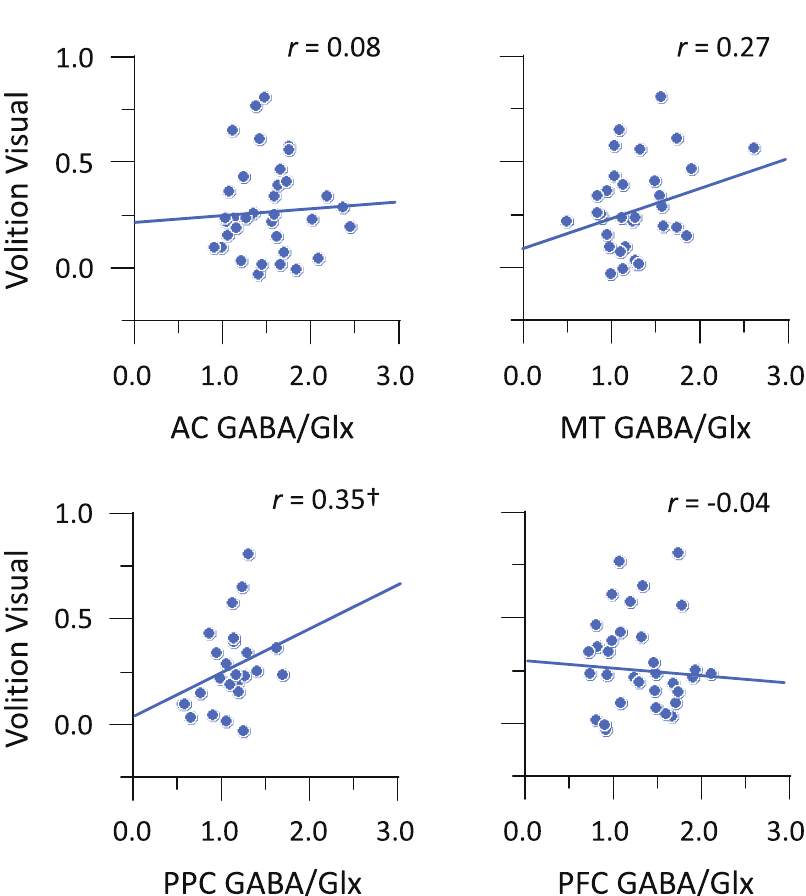
Figure 7. Correlations between MRS measure and volitional control for moving plaids. Amounts of effective volitional control as a function of GABA/Glx ratio. † p <